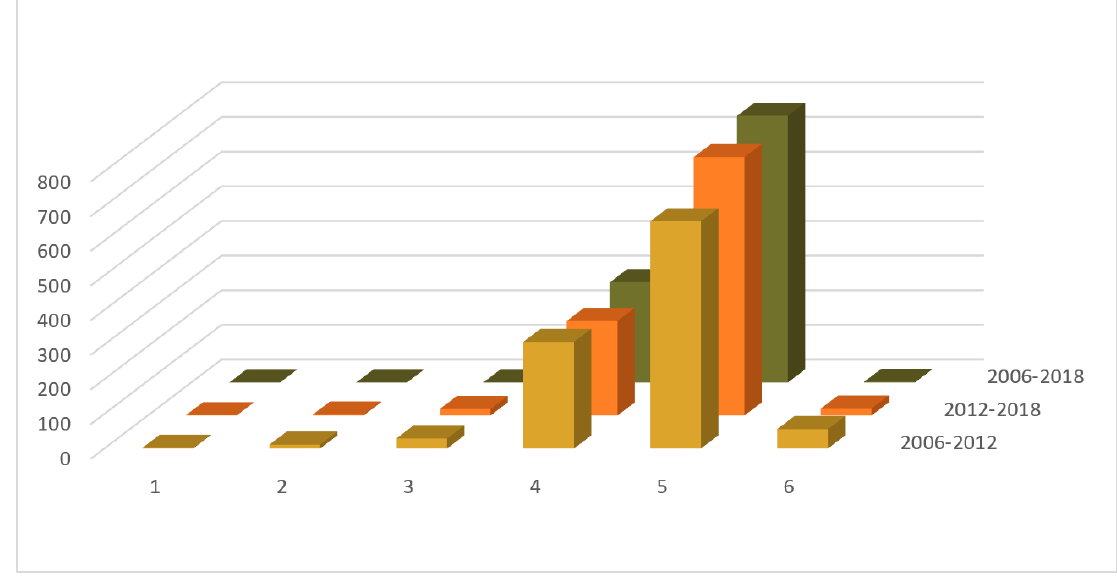
Figure 7. LCC classes. 3(a)—classification for 2018 based on CLC classes.